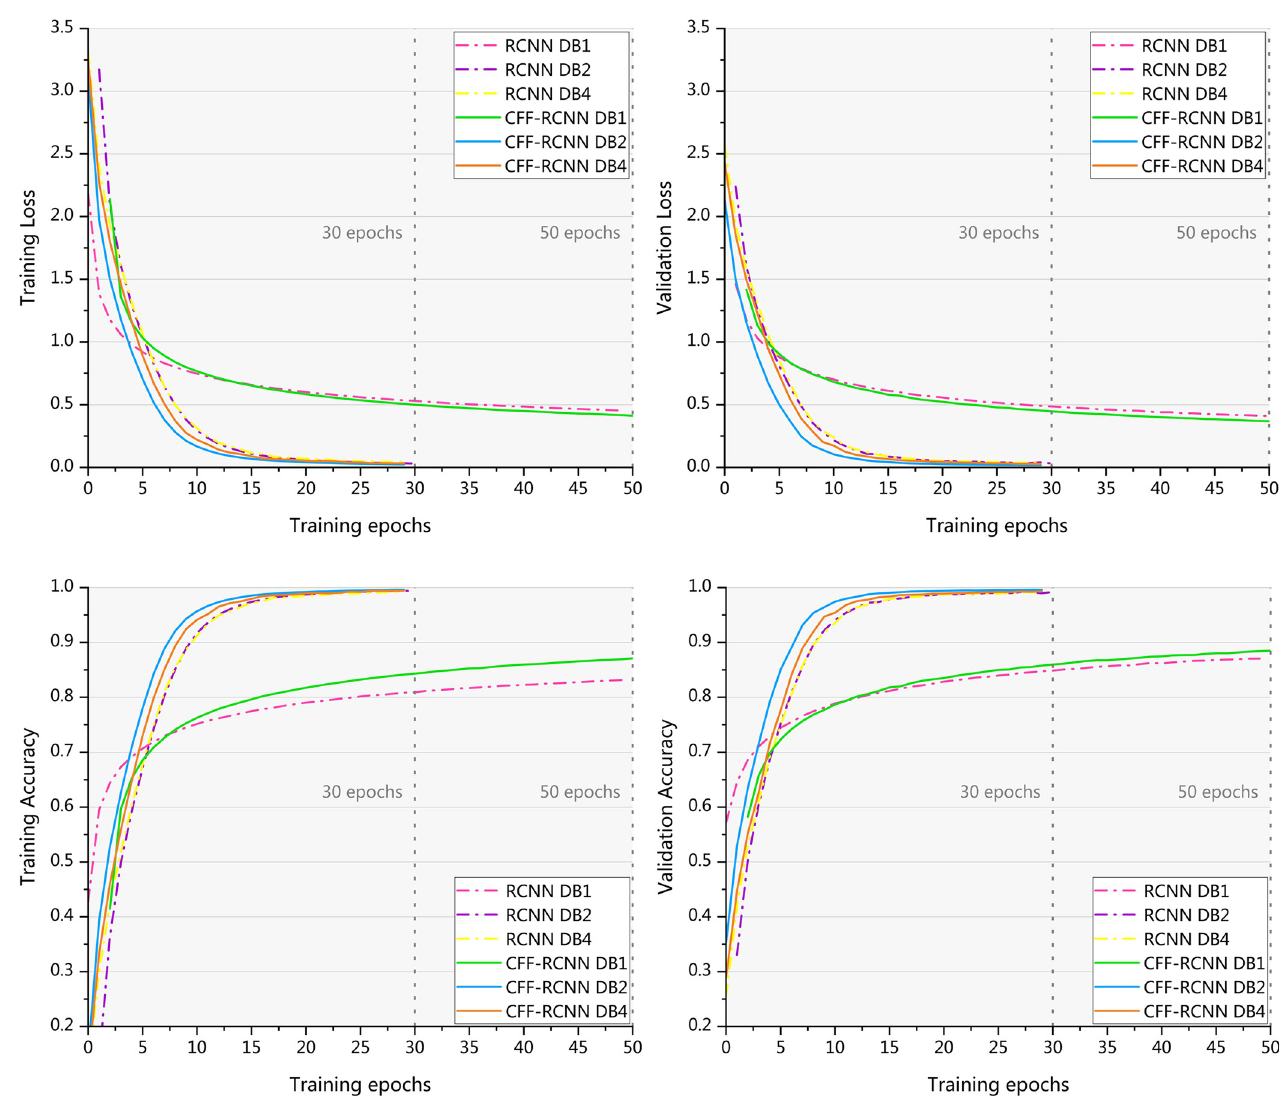
Fig 7. Loss and accuracy of the training and validation sets of the RCNN and CFF-RCNN on DB1, DB2 and DB4.